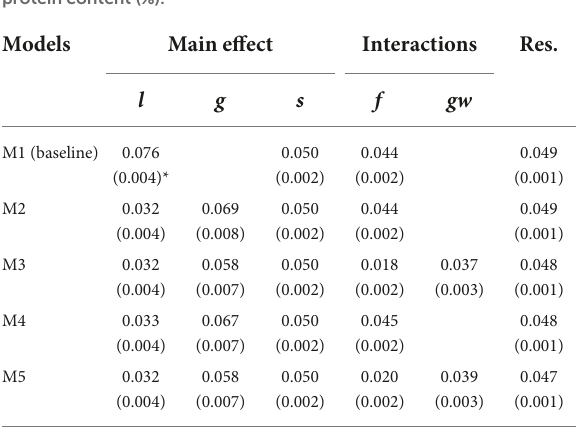
TABLE 5 Posterior mean of variance components for protein content (%).